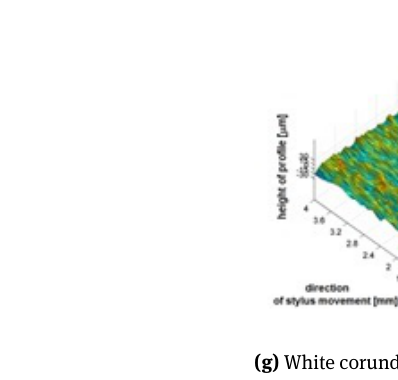
Figure 8: 3D appearance of blasted